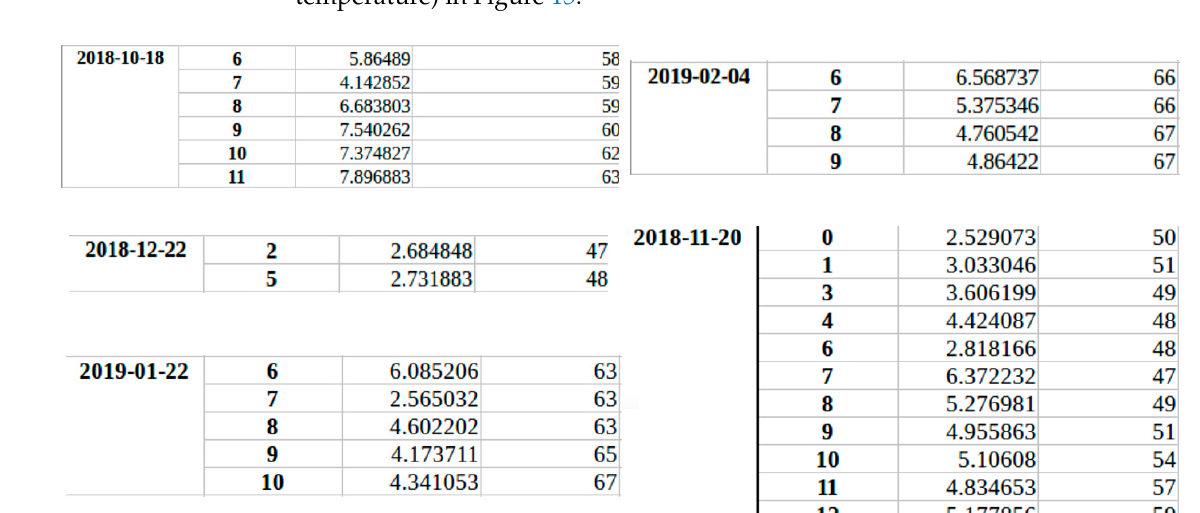
Table 8. Timeslots with high HVAC consumption despite low temperatures. Hour 0